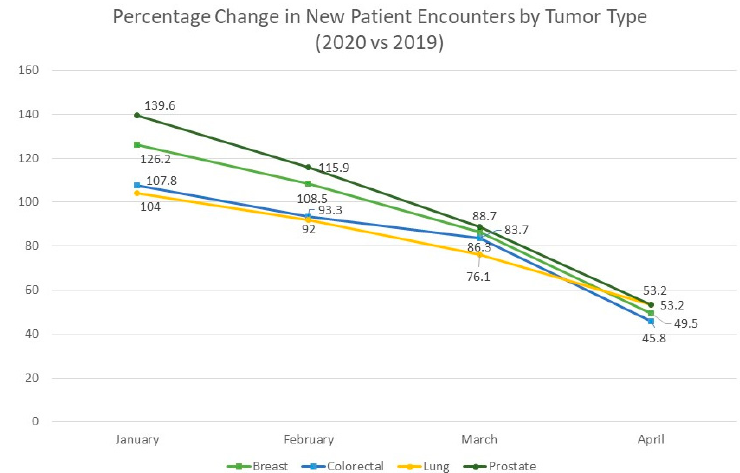
Figure 2. Decline in patient encounters during COVID-19 pandemic by cancer type. Data from “Effects of the COVID-19 Pandemic on Cancer-Related Patient Encounters.” JCO Clin. Cancer Informatics (2020).